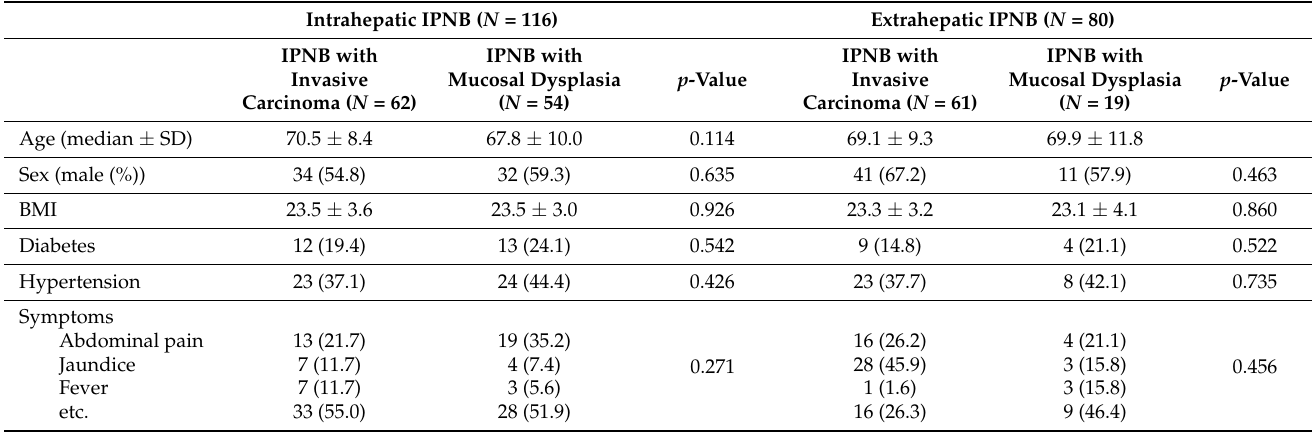
Table 1. Clinical and radiologic characteristics for predicting malignancy in univariate